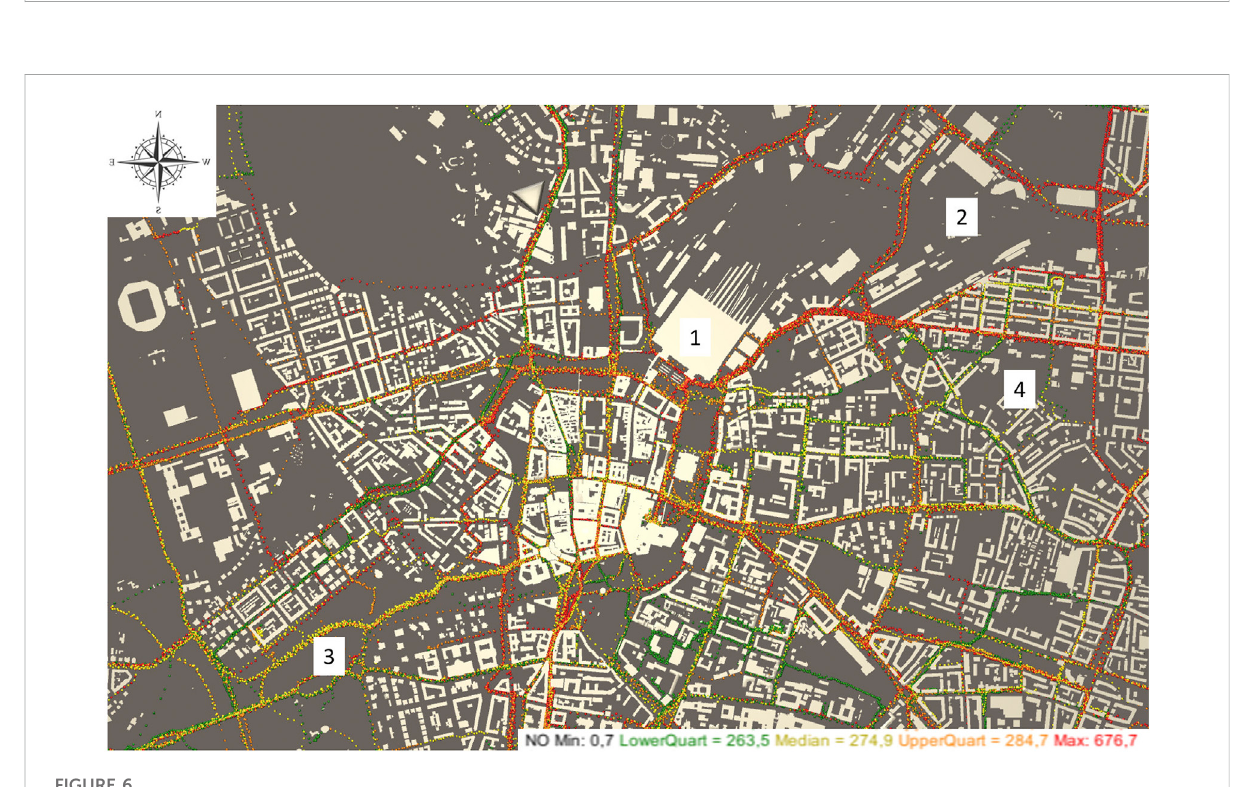
FIGURE 6 Patterns of the NO distribution measured by the mobile